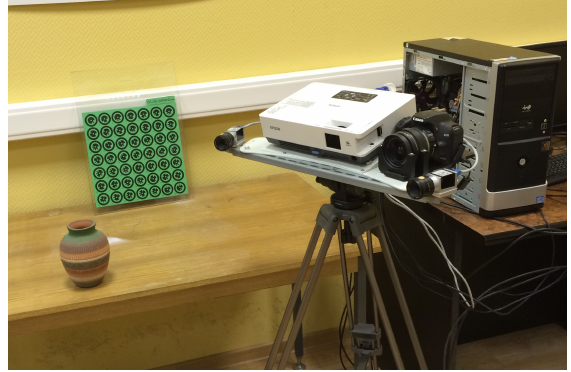
Figure 2. Photogrammetric